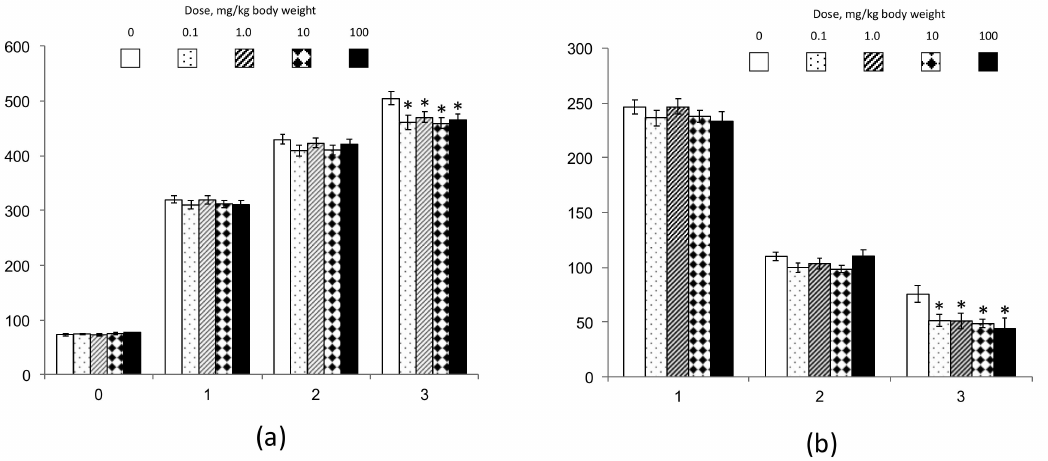
Figure 4. Average body weight ( a ) and monthly weight gain ( b ) of rats in groups 1–5 during the experiment. The x-axis—time, months; y-axis—the average body weight ( a ) or the average increase of body weight ( b ); *—di ff erence with group 1 is significant, p < 0.05, Mann–Whitney U